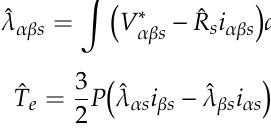
Figure 6. Torque-flux scalar control scheme. The methods in Figures 5 and 6 are relatively simple to implement, with the second enabling precise control of the machine’s operating point in a steady-state. A further advantage of scalar methods is that operation near or at the inverter voltage limit is relatively easy to achieve. However, the fact that coupling between flux and torque is not considered for the control design requires a very slow dynamic response to avoid over currents and torque pulsations. 3.1.3. Torque/Flux Scalar Control with Feedforward The dynamic response of the closed-loop V/F control scheme in Figure 6 can be enhanced by adding two feedforward terms, as can be seen in Figure 7. The first uses the desired V/F characteristic to provide the base value of the stator voltage magnitude 𝑉 (cid:3046)_(cid:3049)(cid:3033)∗ , with the rotor flux regulator providing the incremental voltage required to track the desired rotor flux with no error. The second provides the base value for the slip 𝜔 (cid:3046)(cid:3039)_(cid:3033)(cid:3033)∗ , which is obtained from the desired torque and the estimated rotor flux using (12). The torque regulator corrects the slip so that the desired torque is followed with no error.